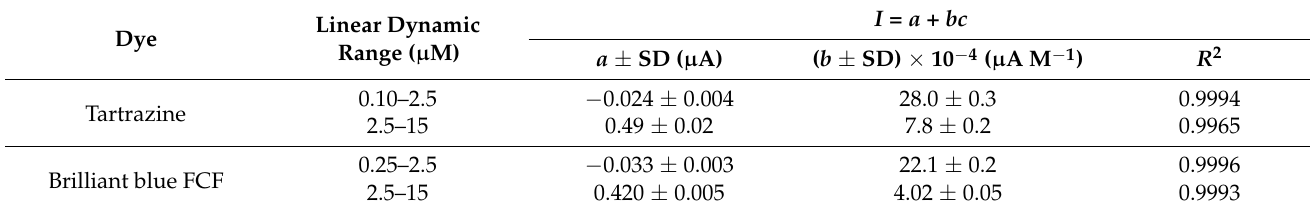
Figure 9. Baseline-corrected differential pulse voltammograms of equimolar mixtures of tartrazine and brilliant blue FCF on the MnO 2 nanorods-based sensor in phosphate buffer pH 7.0: ( a ) concentration range is 0.10–2.5 μM; ( b ) concentration range is 2.5–15 μM. Pulse amplitude = 75 mV, pulse time = 25 ms, υ = 20 mV s − 1 . Table 4. Calibration graphs parameters for tartrazine and brilliant blue FCF.